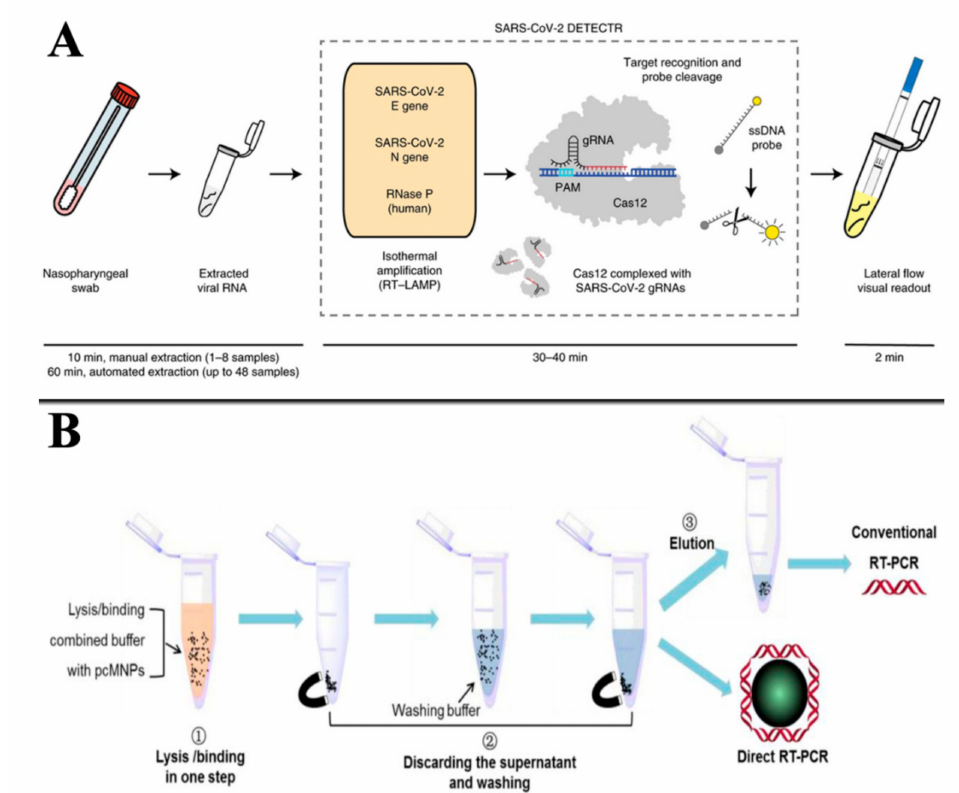
Figure 3. RNA extraction method for the detection of SARS-CoV-2: ( A ) conventional RNA extraction in Cas12-based detection; ( B ) magnetic nanoparticle-based viral RNA extraction in RT-PCR detection. Reproduced from [46,47] with permission from Elsevier and